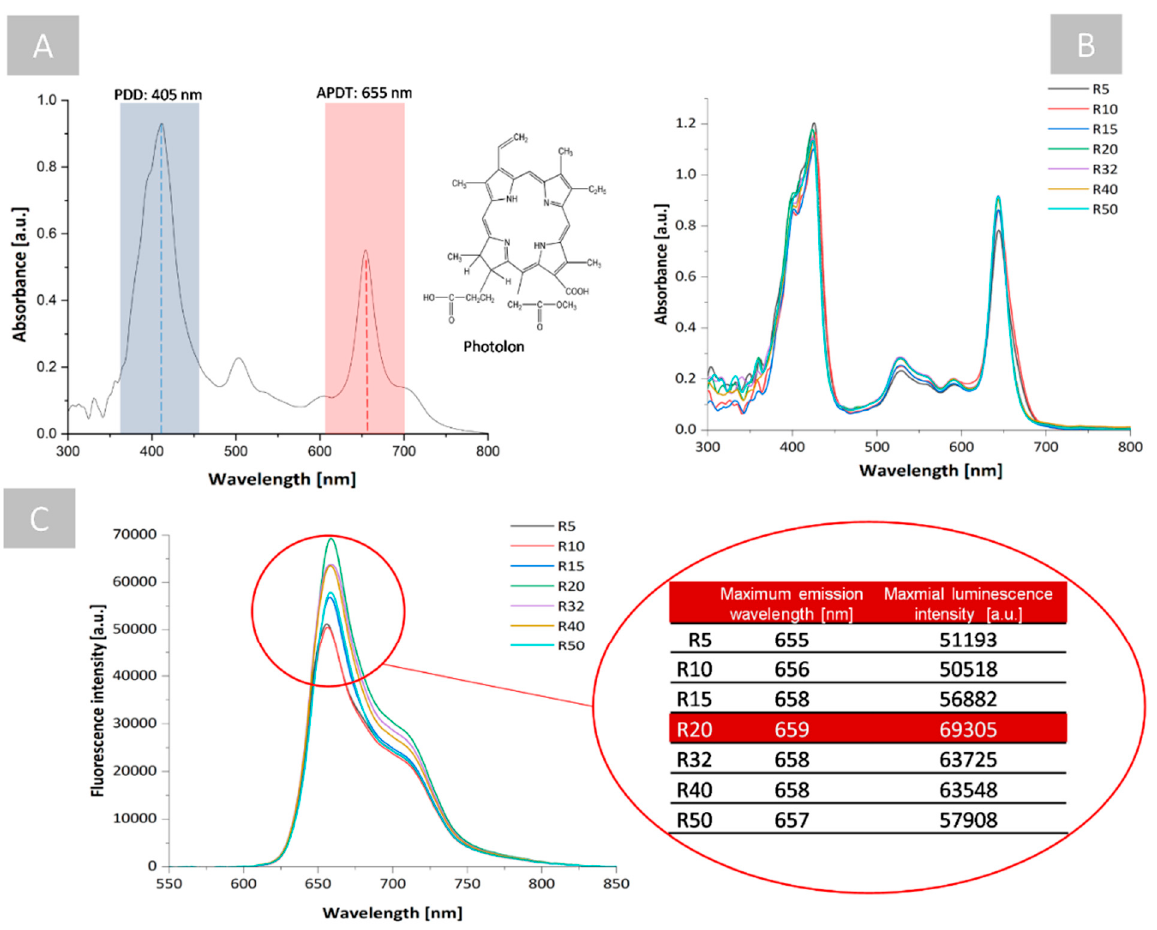
Figure 3. Exemplary results of the spectrophotometric measurements: ( A ) Ph absorption in ethyl alcohol. ( B ) Ph absorption and ( C ) luminescence in different silica coatings (excitation wavelength: 405 nm) with a table demonstrating the variation of the luminescence intensity.